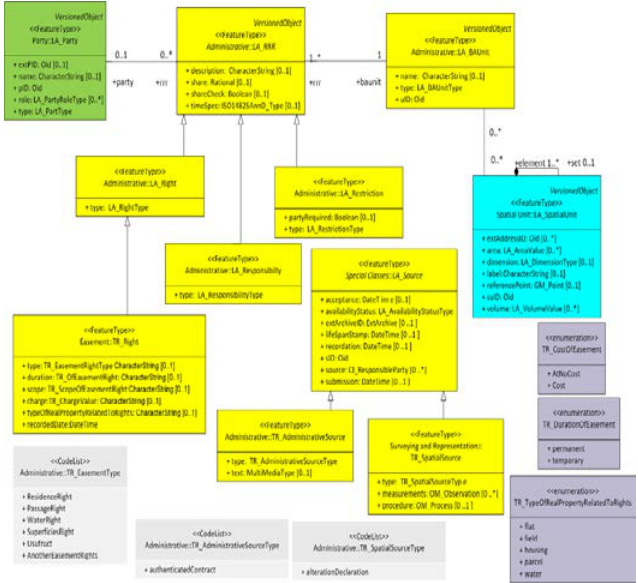
Figure 3: Schema of relationships between classes concerning Parties and Rights (Easements) to Properties of Turkish temporal cadastral data